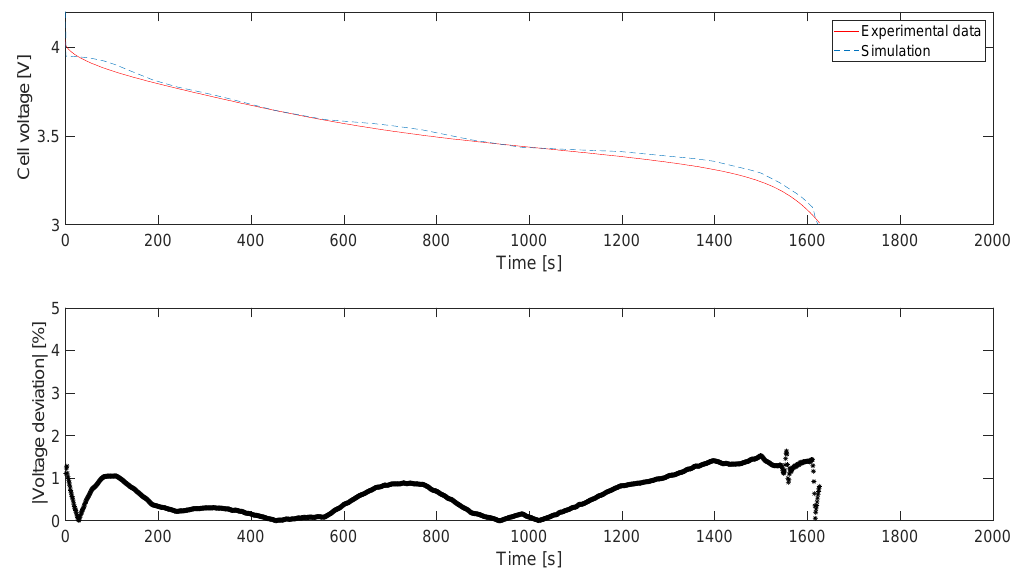
Figure 18. ( Upper ) Cycled cell voltage during high constant current discharge at 25 ◦ C room temperature; ( Lower ) Absolute value of the voltage deviation between experimental and simulations data.